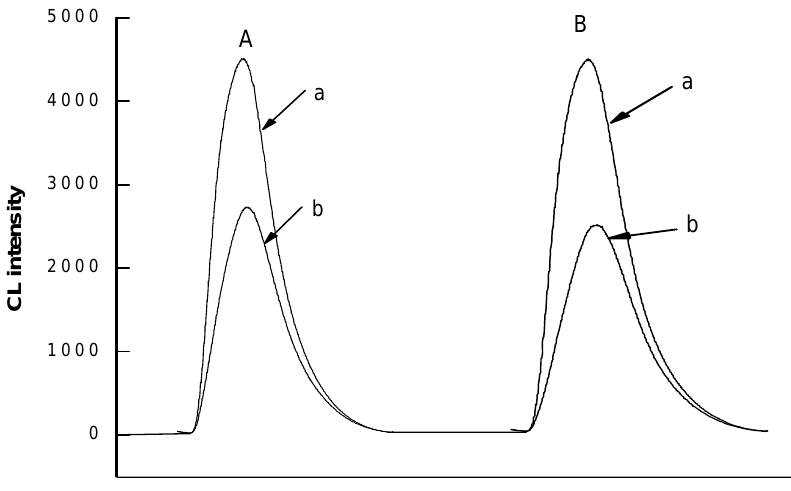
Figure 2. The CL characteristics of the reaction system. A. a, Blank: 1.0×10 -5 mol/L +1.0×10 -4 mol/L β -cyclodextrin+1.0×10 -4 mol/L luminol; b, a+ 10 ng/mL hydroquinone; B. a, KMnO 4 Blank: 1.0×10 -5 mol/L KMnO +1.0×10 -4 mol/L β -cyclodextrin+1.0×10 -4 mol/L luminol; b, a+ 10 4 ng/mL catechol.